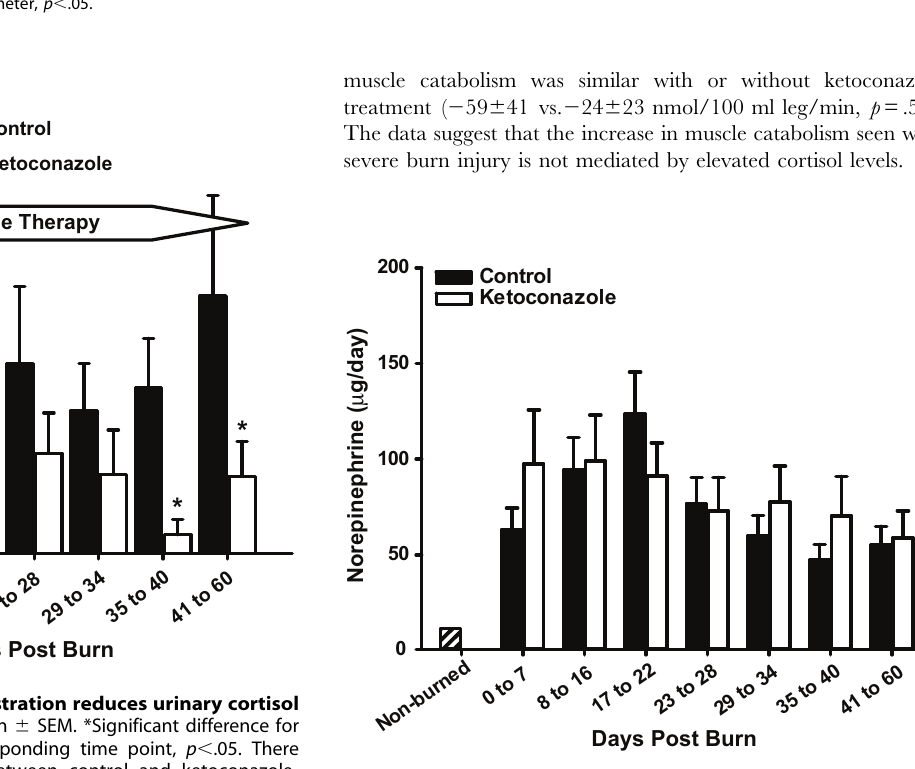
TBSA = total body surface area. LOS = length of stay. Data are presented as means 6 SEM, counts, or percentages. *Significant difference for control versus ketoconazole for corresponding parameter, p , .05.